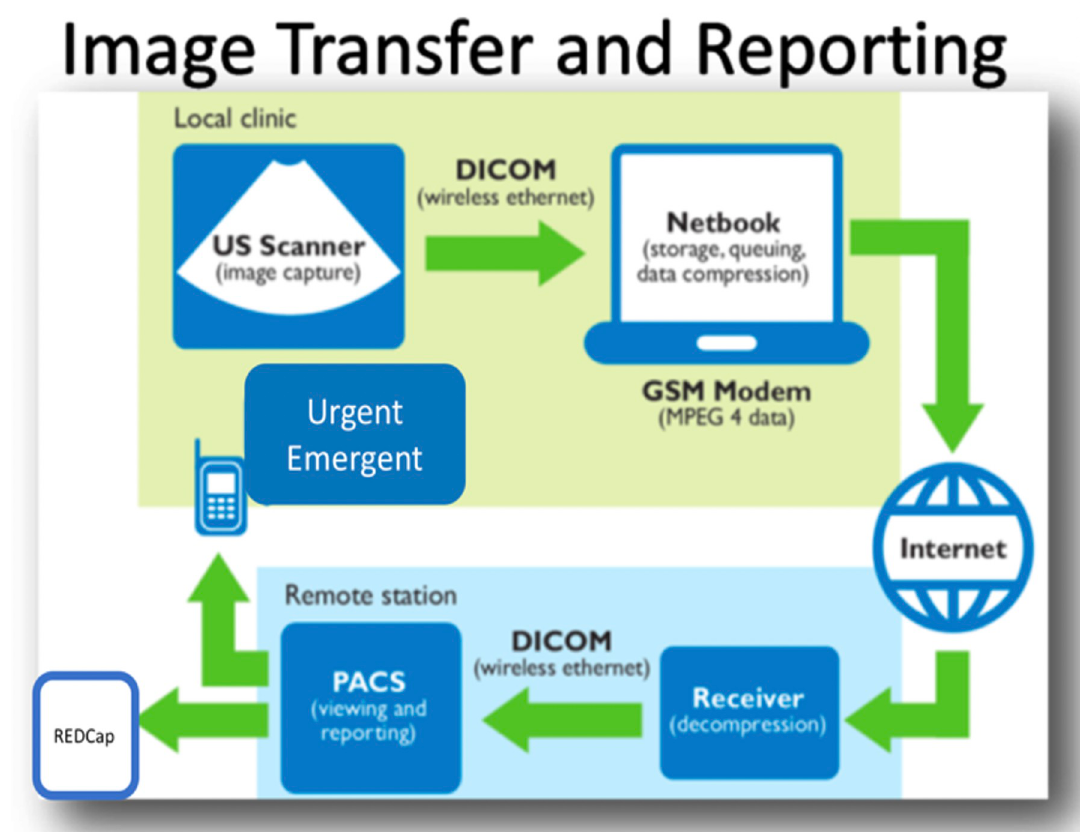
Fig 1. Operational workflow. This figure depicts the operational flow for a patient from intake through final disposition. Steps 1, 2 and 5 take place in Gulu, step 3 takes place in the cloud (data uploaded in Gulu and downloaded in Kampala) and step 4 takes places at Uganda Heart Institute in Kampala. Abbreviations: